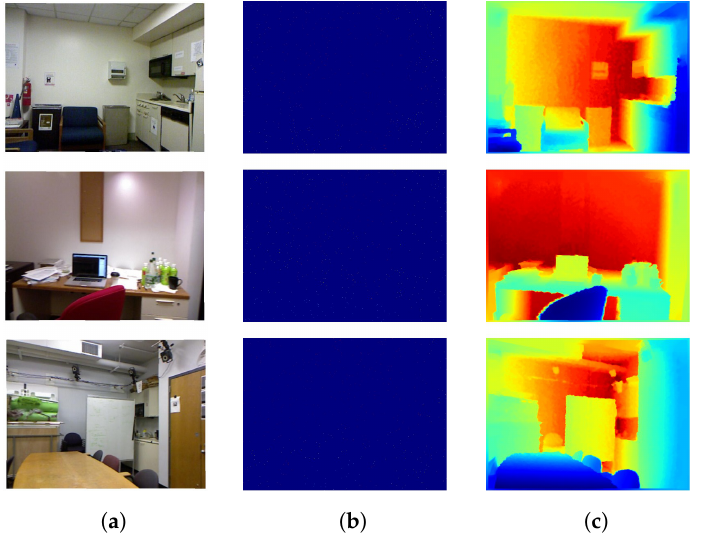
Figure 8. Nyu-v2 depth dataset. Part ( a ) shows the aligned RGB images. Part ( b ) depicts the sparse Kinect depth maps, which are generated by randomly sampling only 500 points from the ground truth. Part ( c ) represents the fully dense ground-truth depth maps. Colorization is applied on Kinect sparse depth maps and corresponding ground-truth to generate visualizations. ( a ) RGB Image. ( b ) Kinect sparse Depth Map. ( c )